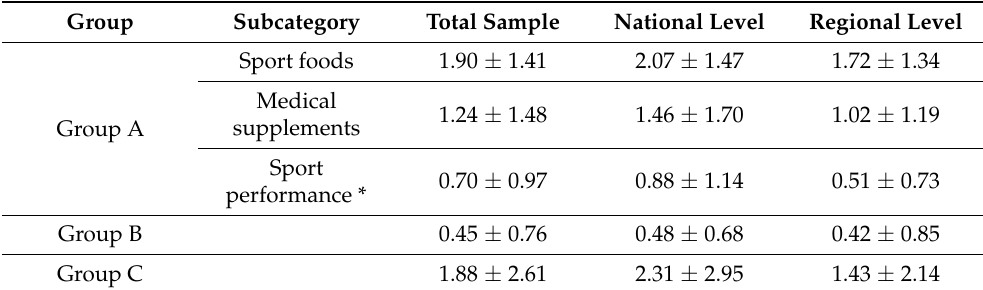
Table 2. Number of SS consumed by national and regional level swimmers in the specific category established by the AIS [4]. Group Subcategory Total Sample National Level Regional Level Sport foods 1.90 ± 1.41 2.07 ± 1.47 1.72 ± 1.34 Medical 1.24 ± 1.48 1.46 ± 1.70 1.02 ± 1.19 supplements Group A Sport 0.70 ± 0.97 0.88 ± 1.14 0.51 ± performance *